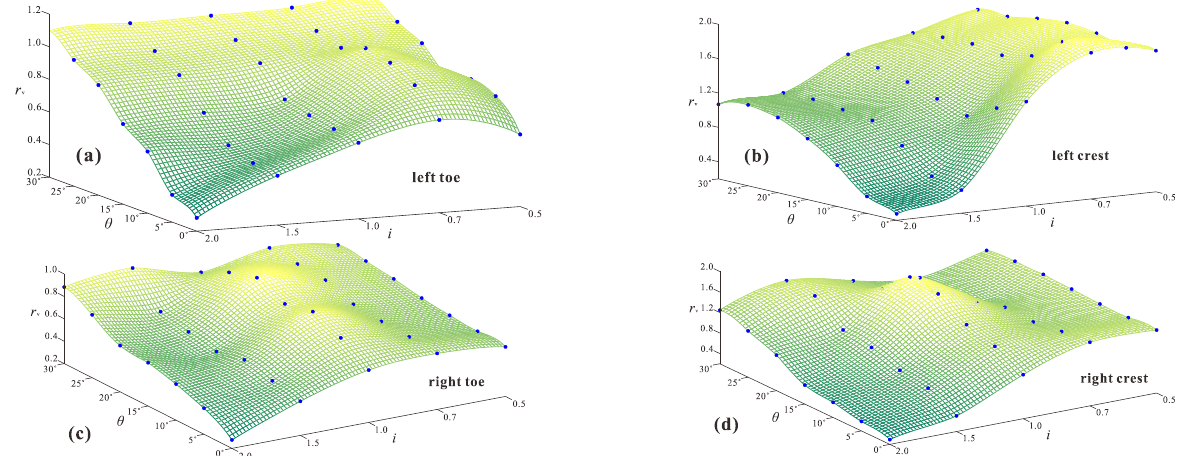
Figure 26. Variations of the vertical amplification ratios ( r v ) of PGA at the observation points (( a ) left toe, ( b ) left crest, ( c ) right toe and ( d ) right crest) with varied angles of wave incidence at different slope inclinations.